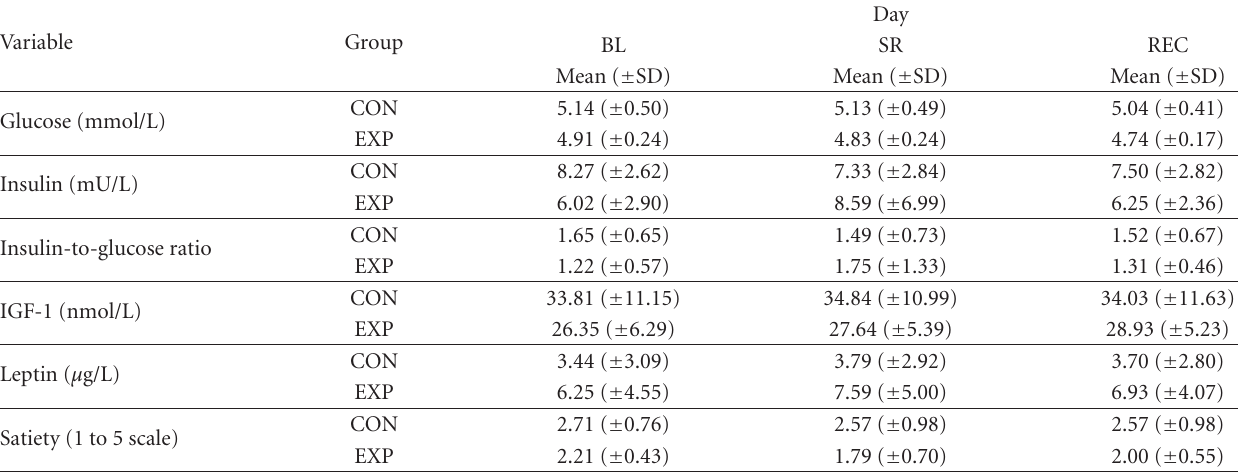
Table 2: Descriptives of the